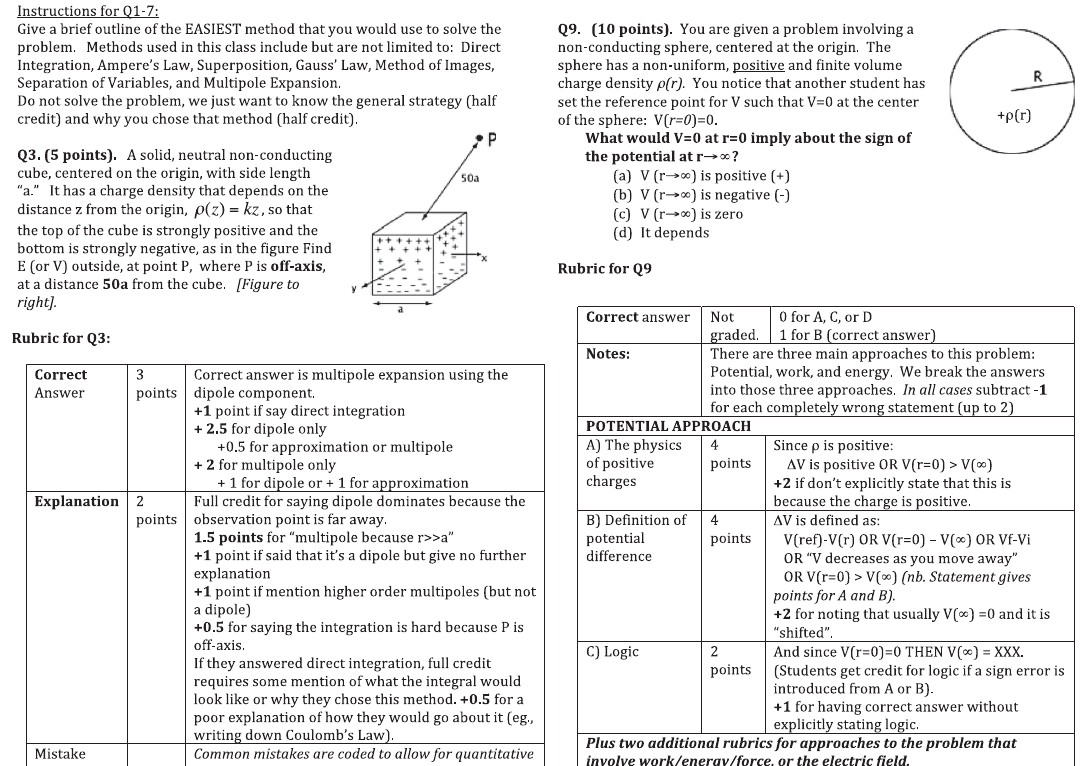
FIG. 2. Two problems from the CUE, Q3 (5 points) and Q9 (10 points), and their accompanying grading